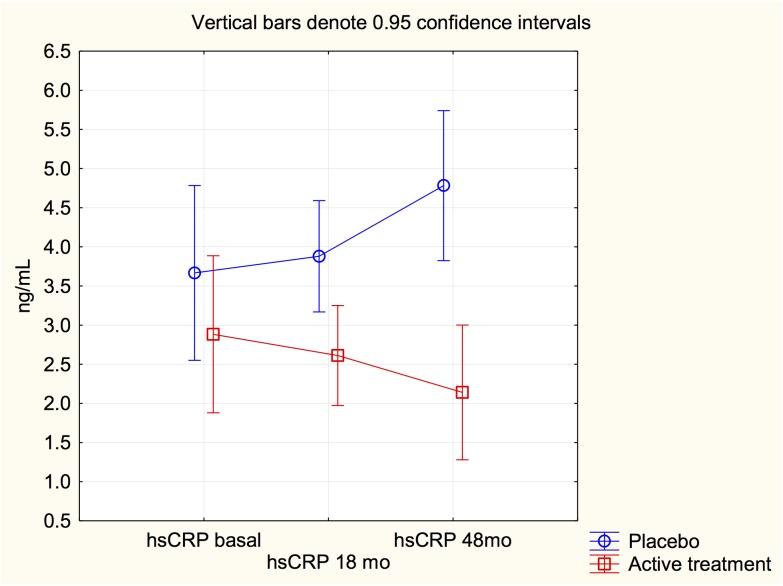
Graph illustrating C-reactive protein measurements at study start, after 18 months and at study stop at 48 months in the study population given selenium and coenzyme Q10 combined, or placebo.Note: Analysis according repeated measures of variance.